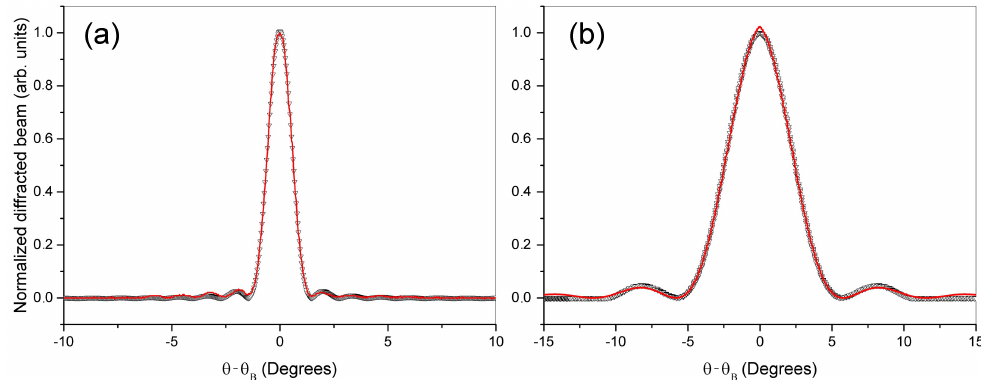
Figure 3. Intensity of the diffracted beam as function of the difference between the incidence angle and the Bragg angle for ( a ) thick and ( b ) thin samples. The red curve represents the fit of the experimental data obtained with the Kogelnik theory.